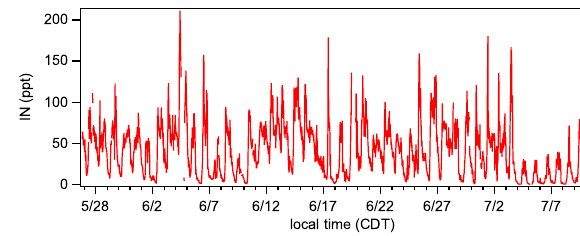
Figure 4. IN observed during SOAS.